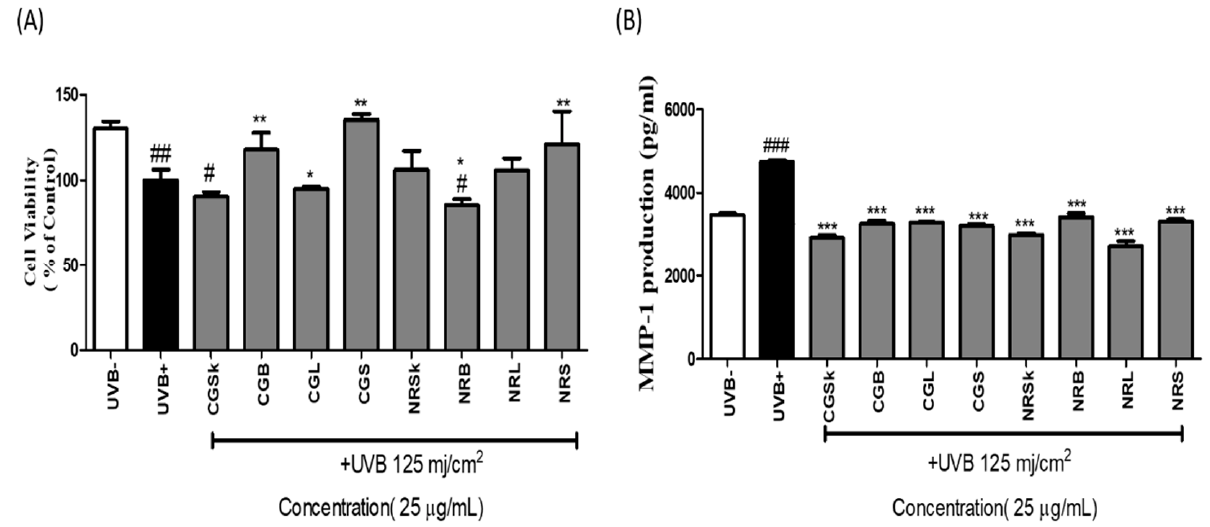
Figure 3. ( A ) Cell viability and ( B ) inhibitory activity upon UVB-induced MMP-1 production of extracts of different organs of C. gunnari (CG) and N. rossii (NR). SK = skin, B = brain, L = liver, S = stomach. Each value is represented as the mean ± SEM of triplicate experiments. (*) p < 0.05, (**) p < 0.01, and (***) p < 0.001 compared to UVB treatment group; (#) p < 0.05, (##) p < 0.01, and (###) p < 0.001 compared to normal control group.